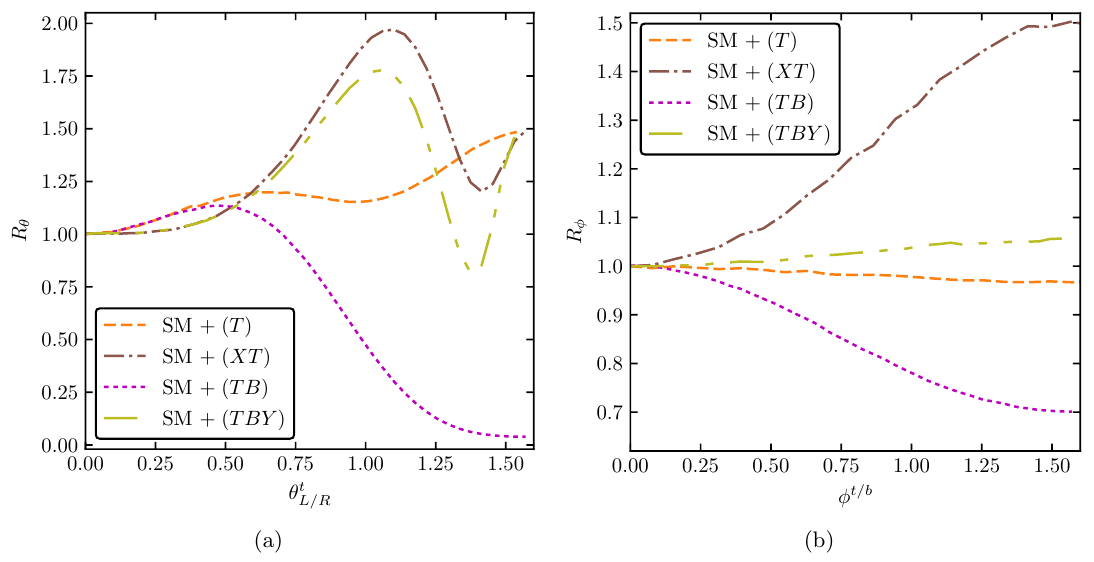
Figure 12 . Total gluon induced cross section for ZH production with additional VLQ multiplets normalized to the gluon induced production in the SM for di(cid:11)erent mixing angles (cid:18) t di(cid:11)erent phases (cid:30) t = (cid:30) b (b). The vector-like quark masses are set to m T = m B = 600 GeV. In the case of the triplet ( TBY ), only m T = 600 GeV is assumed and the mixing angle (cid:18) b the mass m B are calculated accordingly to eq. (5.14) and eq. (5.15b). input parameters with vh@nnlo . For the ( T BY ) triplet, we only (cid:12)x m